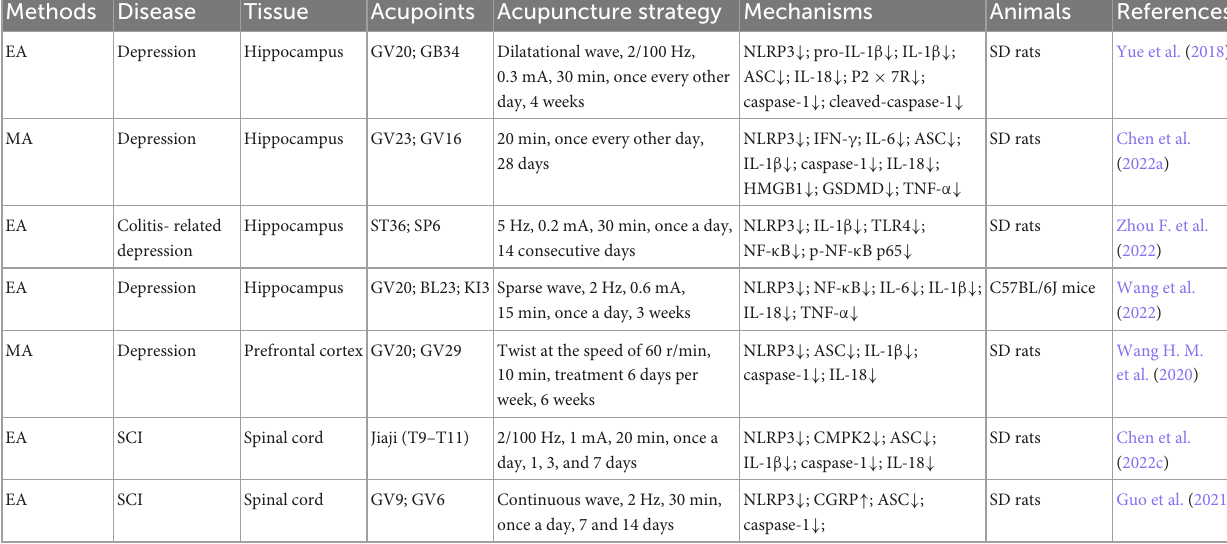
TABLE 2 Acupuncture methods for depression and SCI via NLRP3